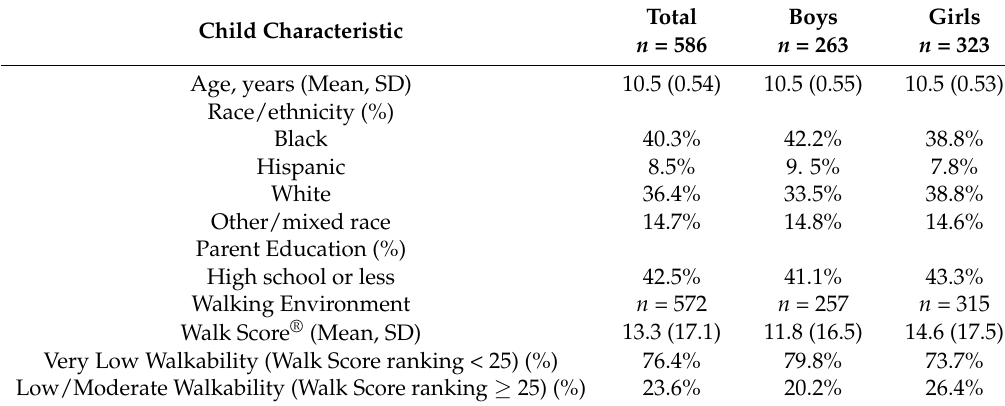
Table 1. Sociodemographic characteristics of 5th grade participants in the Transitions and Activity Changes in Kids (TRACK) Study ( n =